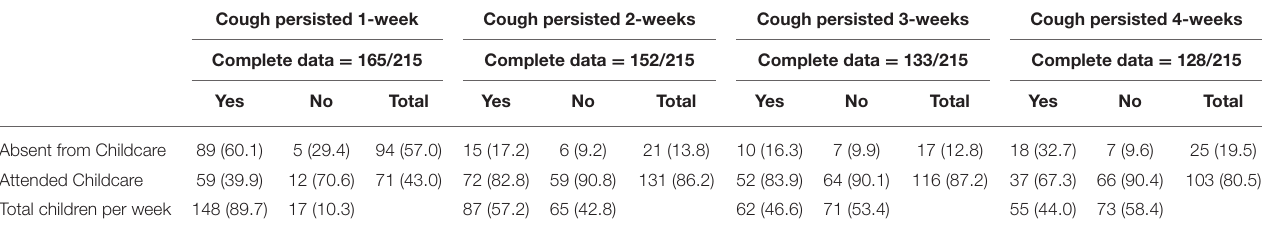
TABLE 4 | Weekly attendance at childcare by cough persistence amongst childcare attendees for whom contact was successful each week and complete data on both cough and childcare attendance were available. Cough persisted